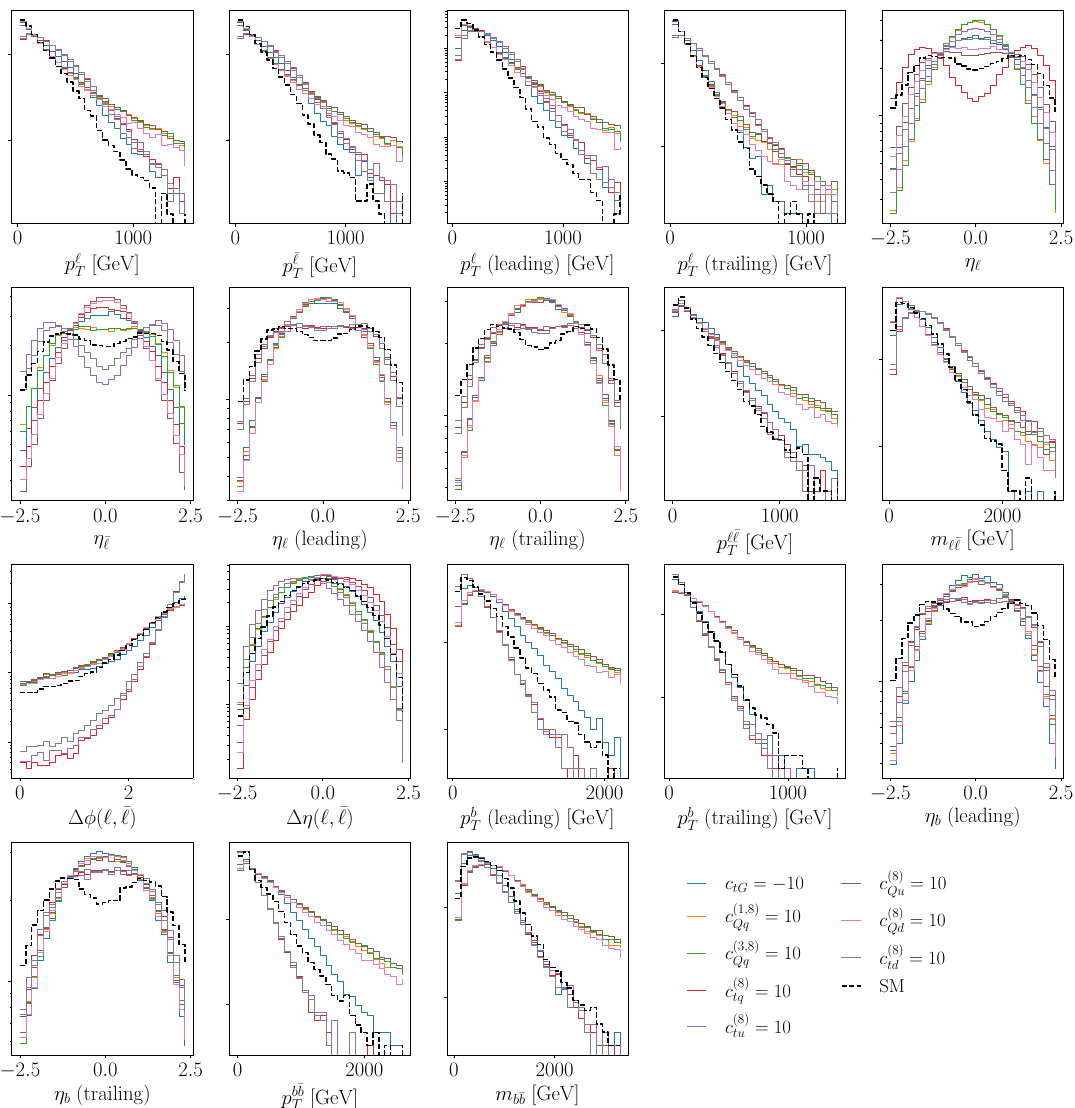
Figure 8. Same as the bottom panels in figure 7 (quadratic-only EFT effects included) for the n k = 18 kinematic features entering the parametrization of the likelihood ratio in the t ¯ t → b ¯ b‘ + ‘ − ν ‘ ¯ ν ‘